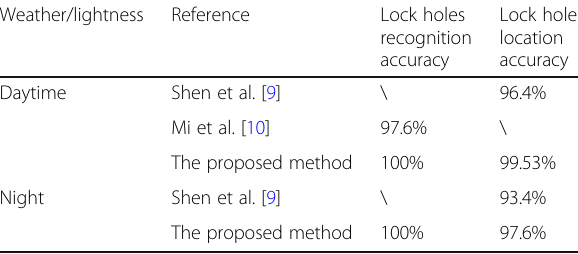
Table 3 Comparison with other results